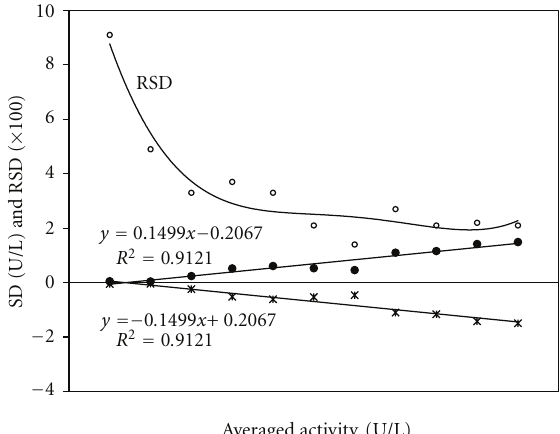
Figure 4: Association of standard deviations (SD) and relative SD (RSD) with averaged ALT activities by the integration strategy. Data were obtained by methods as reported before